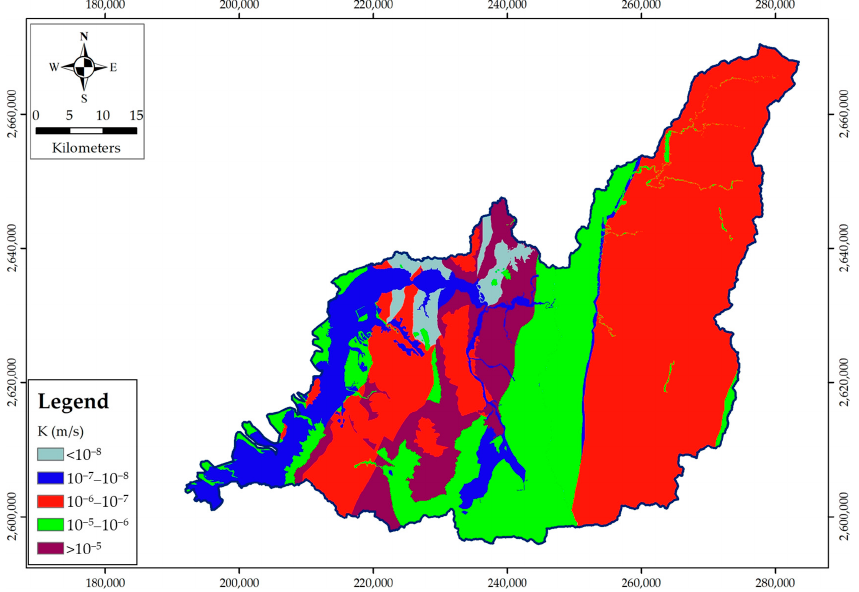
Figure 7. Hydraulic conductivity distribution of the study area.